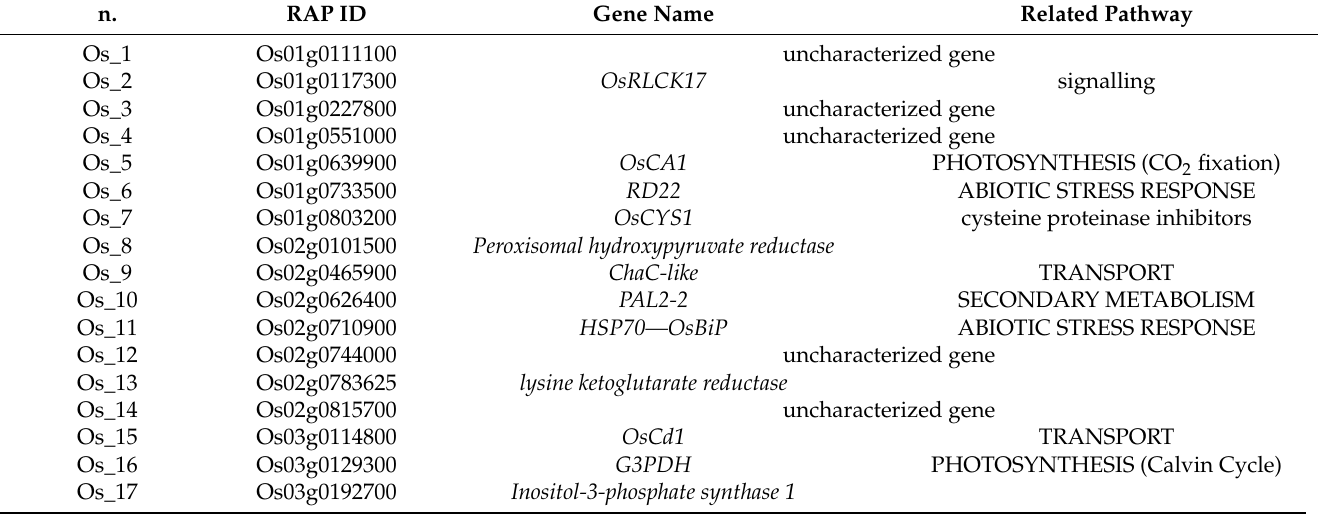
Table 4. Rice Conserved drought tolerance-related (CDT) genes. Where defined, the gene names and the pathways in which these genes are involved are shown.